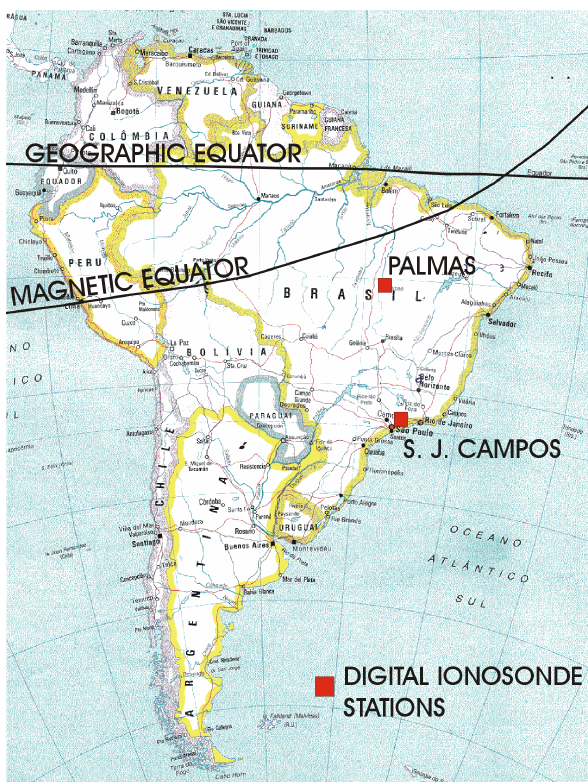
Fig. 1. Map of South America showing the locations of the iono- spheric sounding stations and of the geographic and magnetic equa-